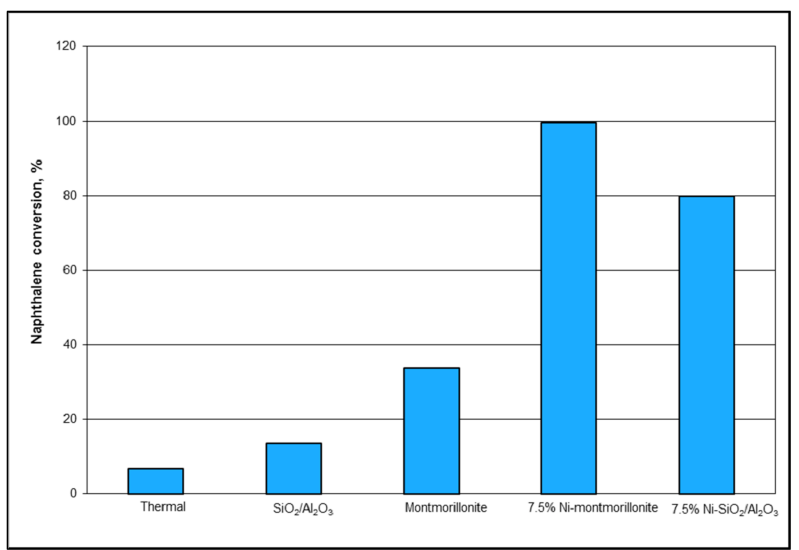
Figure 1. Naphthalene conversion with a catalyst (T—750 ◦ C, S/C—5.0, GHSV—12,800 h − 1 , naph- thalene loading—12 g/Nm 3 ).